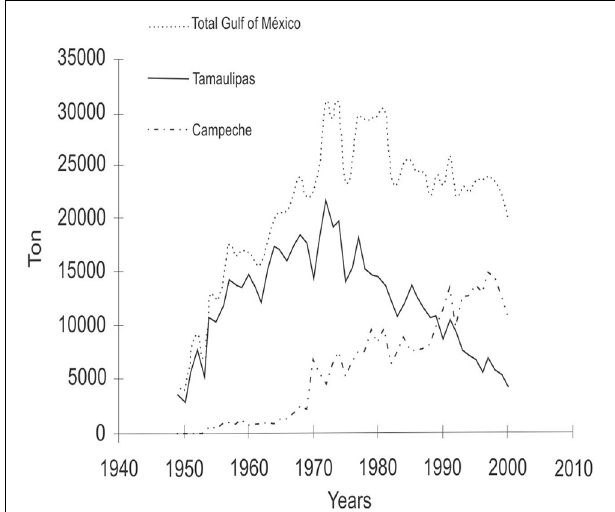
FIGURE 2 | Total shrimp landings in the Gulf of Mexico and in the coasts of Tamaulipas and Campeche, Mexico. (Modified from Díaz de León et al.,